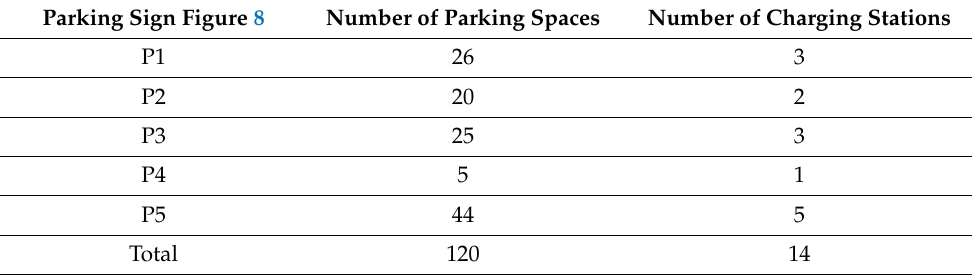
Table 17. Number of stalls and charging stations.